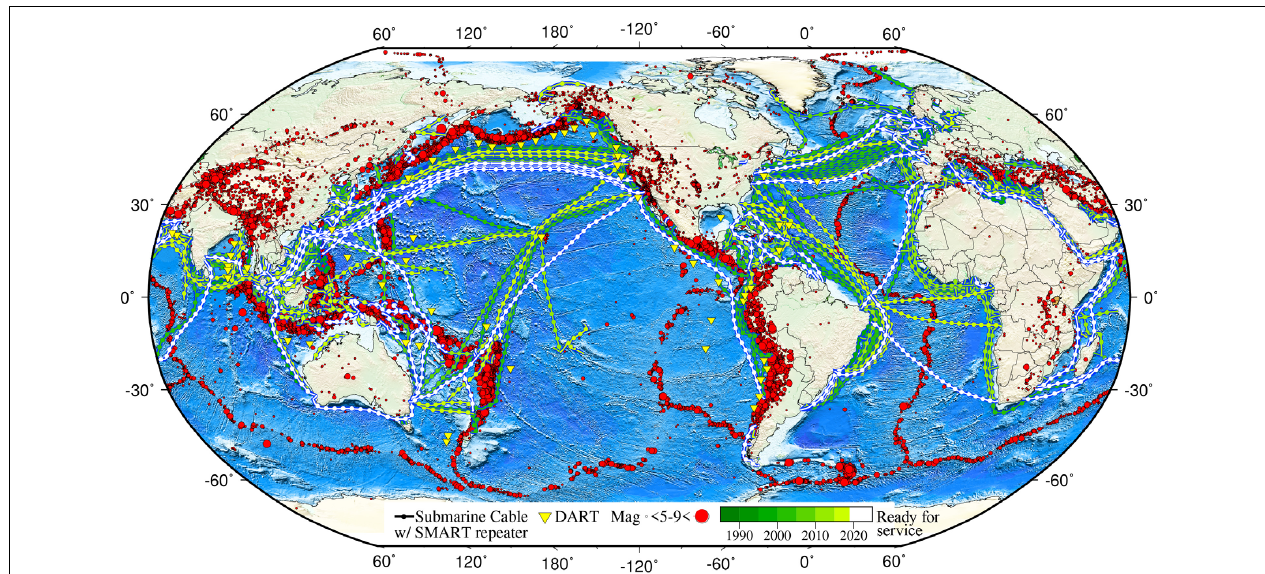
FIGURE 5 | Current and planned submarine cables, locations and magnitudes of historical seismic events, and the existing tsunameter network. Environmental sensors (pressure, acceleration, temperature) can be added to the cable repeaters every ∼ 100 km, gradually obtaining real-time global coverage (for clarity, repeaters are shown only every 300 km). Map by M. Chandler using GMT. Cable data: TeleGeography’s Telecom Resources licensed under Creative Commons ShareAlike. DART system data: NOAA National Data Buoy Center. Seismic data: United States Geological Survey Earthquake